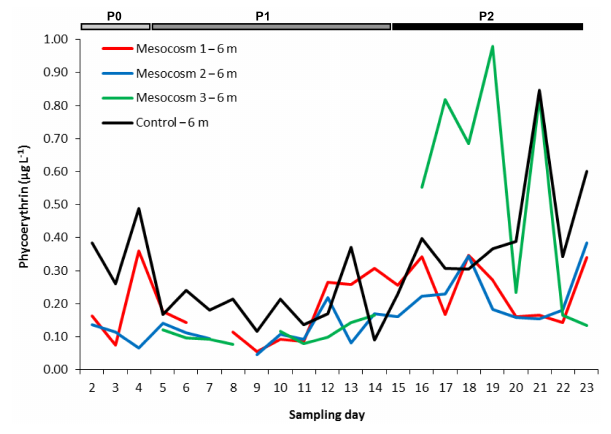
Figure 3. Total phycoerythrin in µgL − 1 at the intermediate depth (6m) inside each mesocosm and in the control area outside of meso- cosms.